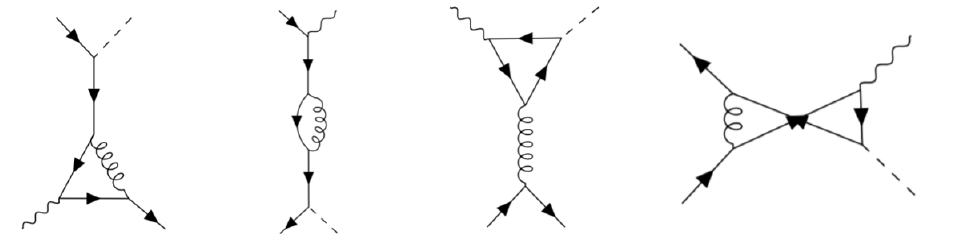
Figure 2 . Examples of Feynman diagrams at one-loop order. The open solid lines in these diagrams represent the b quark with an arrow indicating the (cid:13)ow of its charge. The open dashed (wavy) line denotes the external Higgs ( Z ) boson, while gluons are represented by the curly